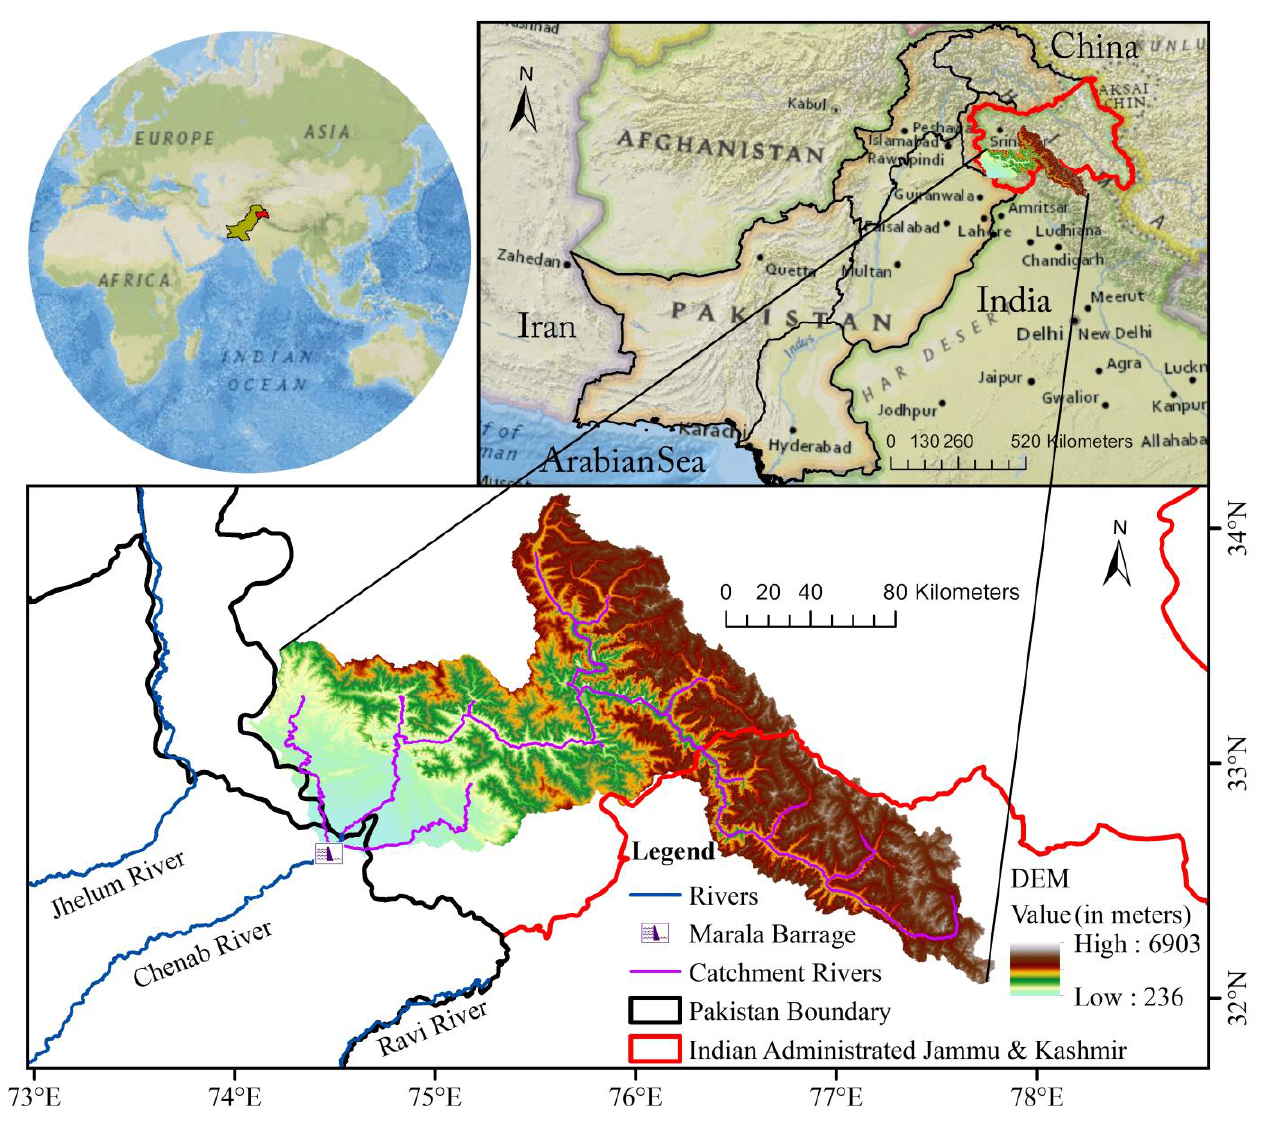
Figure 1. Study area of the Chenab River Basin.